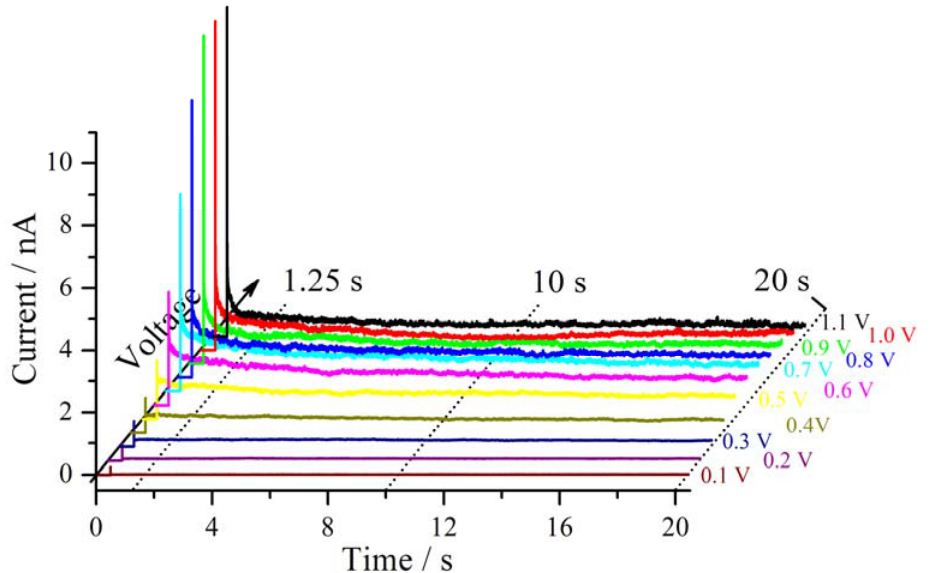
Figure 4. Starting at 0 V, different voltage steps were applied to a Nafion 117 sample in a hydrogen atmosphere at RH = 71% and an applied force of 30 nN between the sample and the tip. The resulting current traces are shown. The break between the measurements was 30